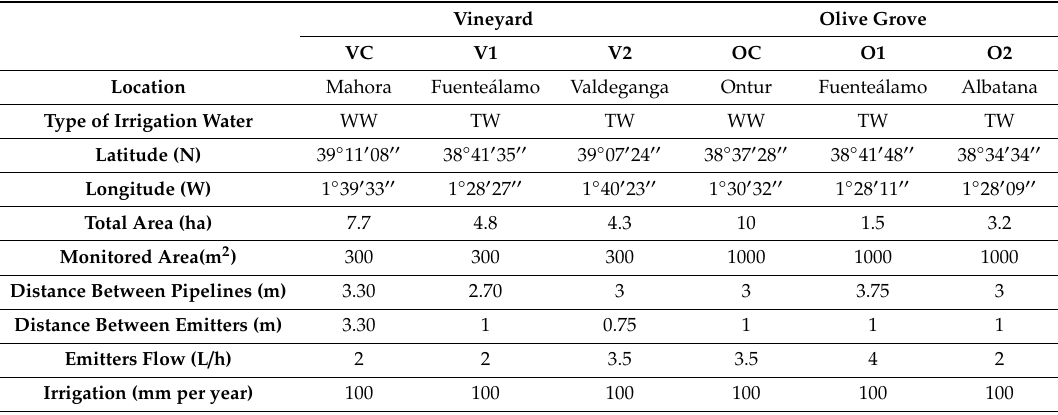
Table 1. Studio plots location and main characteristics of irrigation system. Vineyard Olive